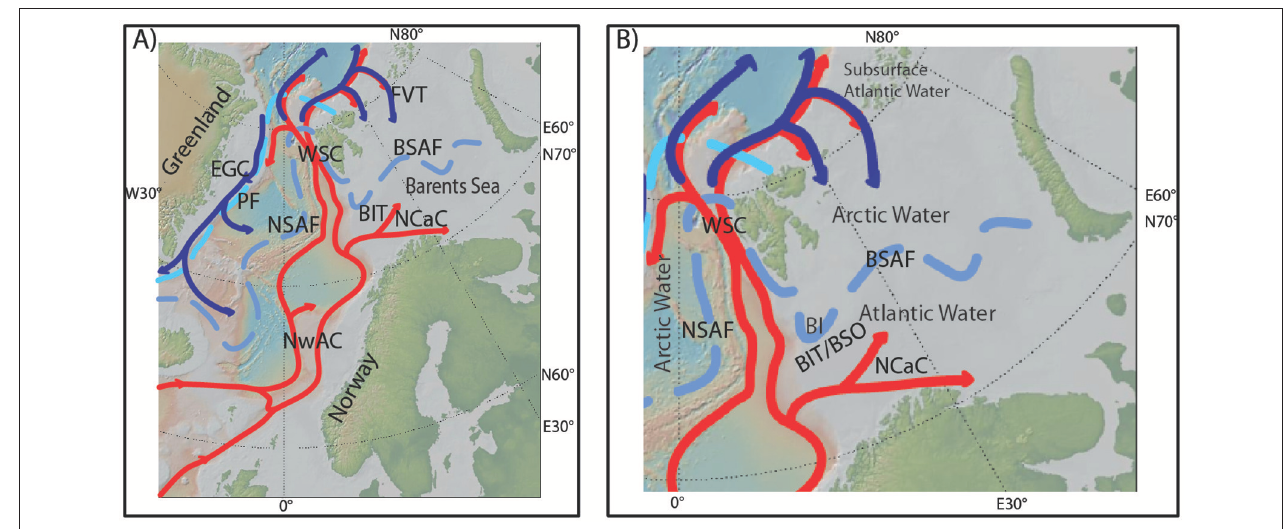
FIGURE 1 | (A) Main features of present-day surface to subsurface oceanography of the Nordic Seas and the Barents Sea. NwAC, Norwegian Atlantic Current; NCaC, North Cape Current; WSC, West Spitsbergen Current; EGC, East Greenland Current; PF, Polar front; NSAF, Nordic Seas Arctic front; BSAF, Barents Sea Arctic front; BIT, Bear Island Trough; FVT, Franz Victoria Trough. (B) Close-up map of the Barents Sea and the main present-day oceanographic features. Atlantic Water is found south of the BSAF, Arctic Water is found north of the BSAF. In the Northern Barents Sea, Atlantic Water is found at the subsurface, underneath the Arctic Water. BIT/BSO, Bear Island Trough/Barents Sea Opening; BI, Bear Island. Maps are created using GeoMapApp,